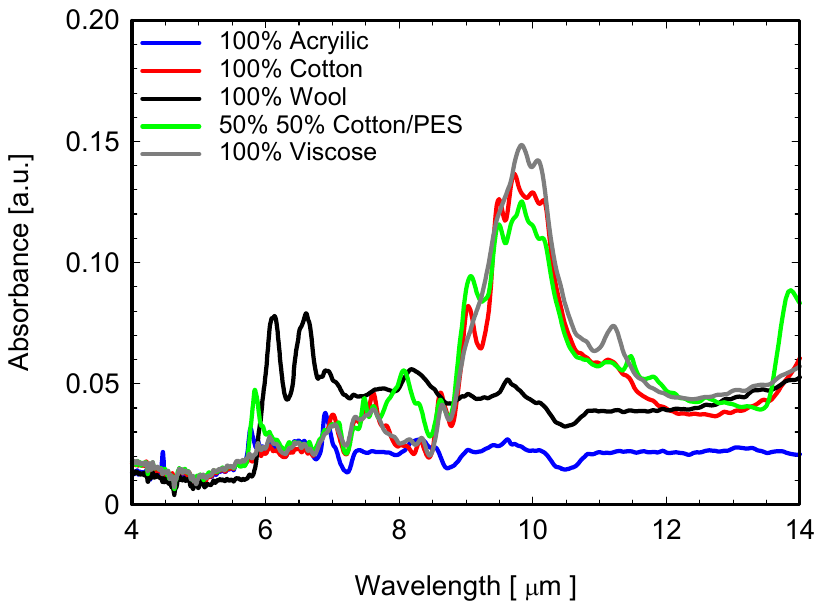
Figure 8. ATR ‐ FTIR spectra of investigated bare fabrics. Inset: details of the ATR ‐ FTIR graphs of uncoated fabrics in the range 4–14 μ m.